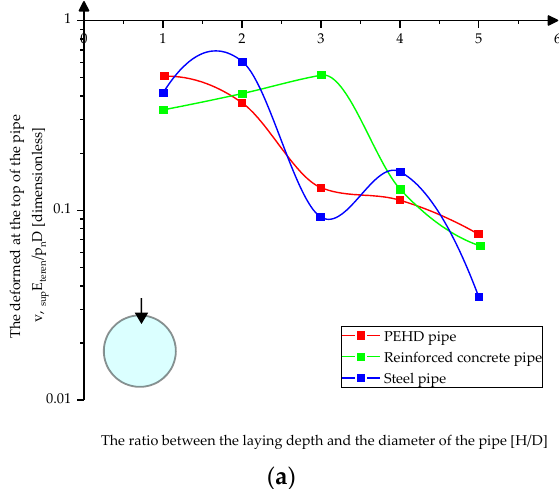
Figure 13. Absolute displacement variation in compacted sand ( a ) at the top of the pipes ( b ) at the bottom of the pipes ( c ) in middle sections.